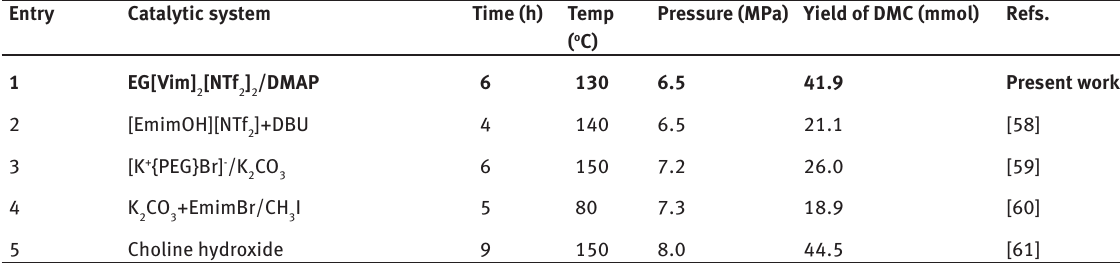
Table 2: Literature survey of ILs on dimethyl carbonate